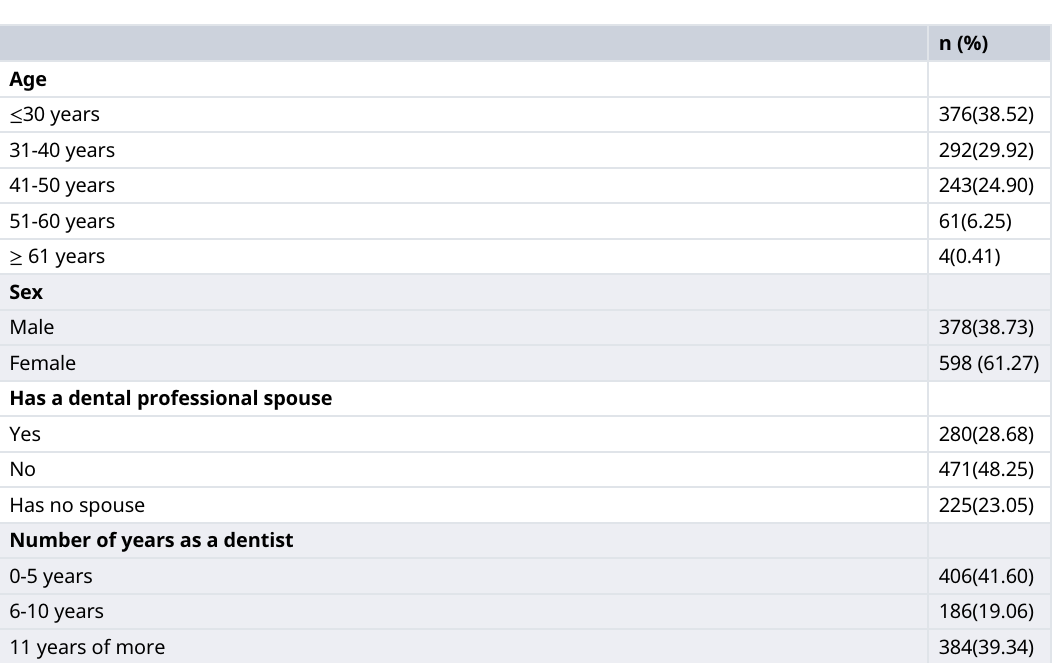
Table 1. The general characteristics of the sample